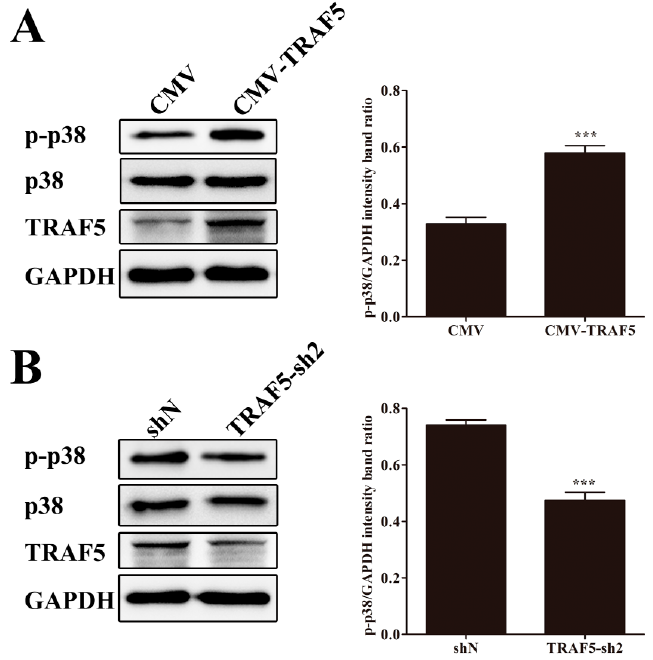
Figure 5. TRAF5 promotes p38 MAPK activation in